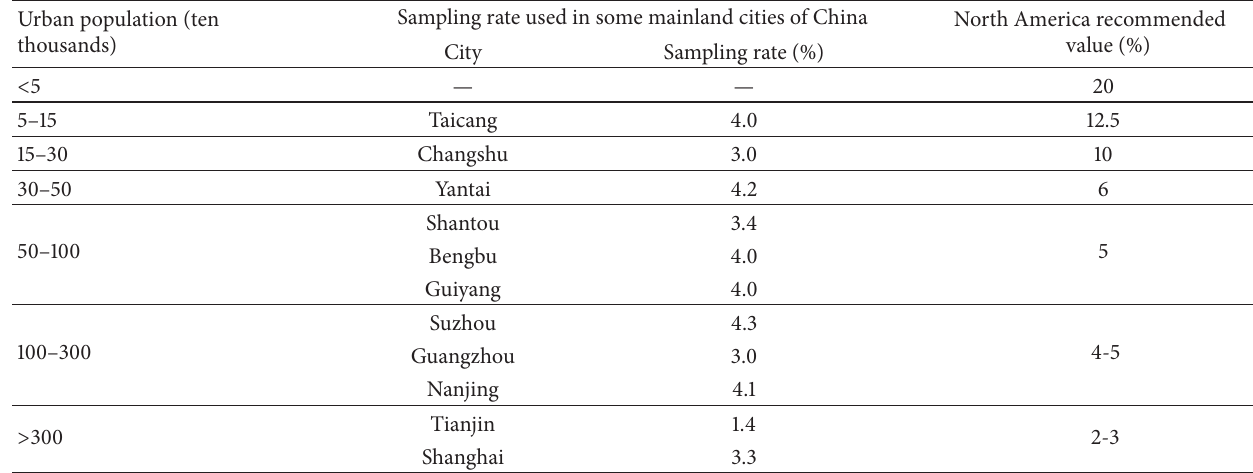
Table 1: Comparison of the sampling rates of urban resident travel surveys in China and abroad [4,